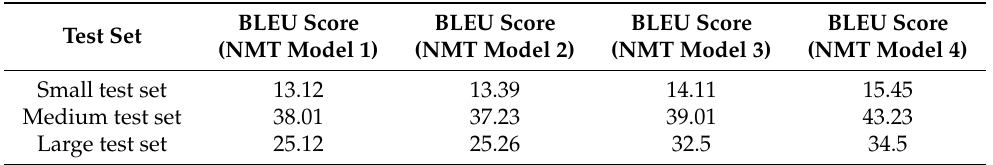
Table 13. BLEU score of the four NMT models.